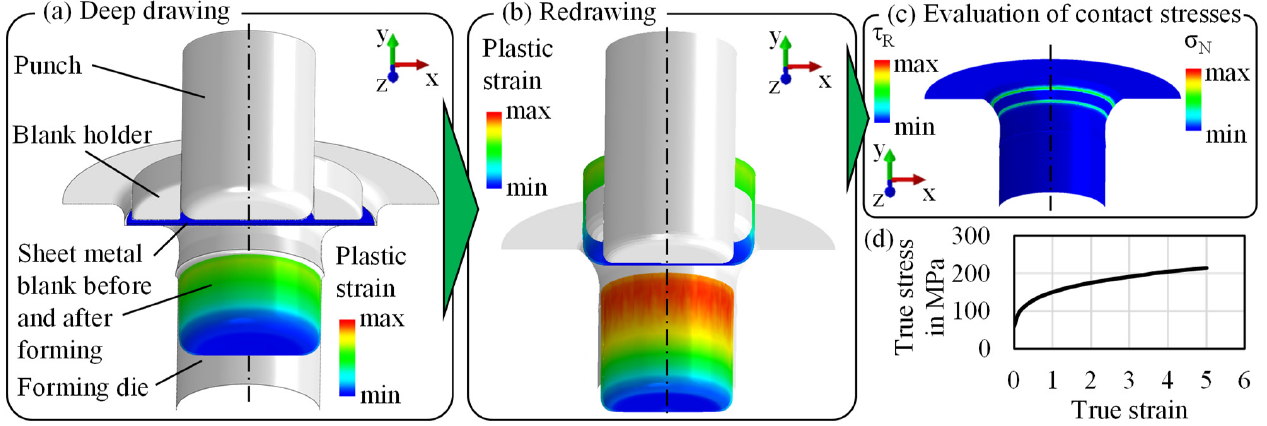
Figure 1. Procedure of the forming simulation: ( a ) deep-drawing, ( b ) first redrawing step, ( c ) evaluation of the contact stresses on the surface of the forming die and ( d ) flow curve of Al 99.8. To reduce the computational time, only 1/12 of the process was modelled and